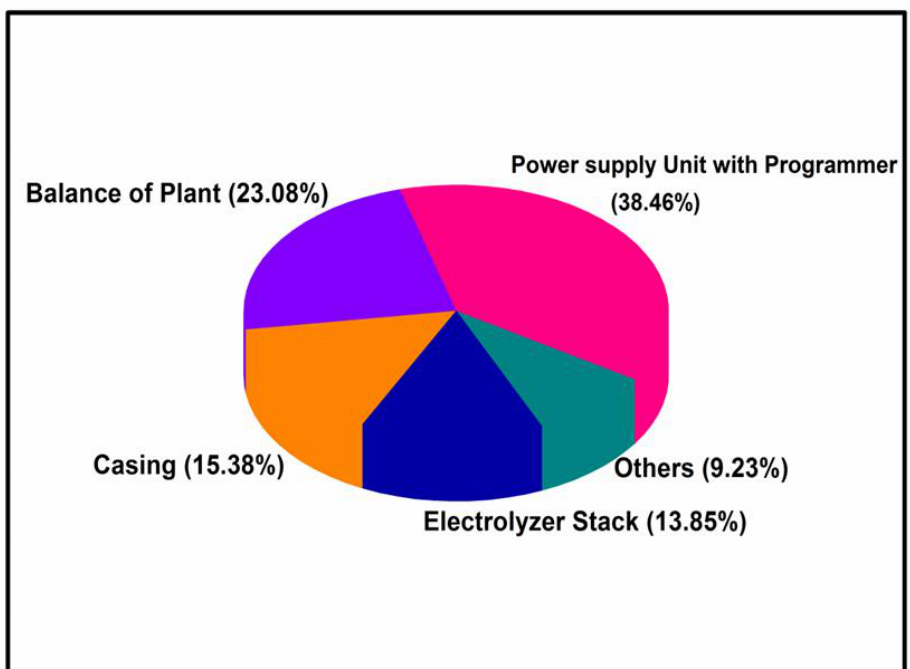
Figure 10. Weight breakdown of the methanol electrolyzer system.